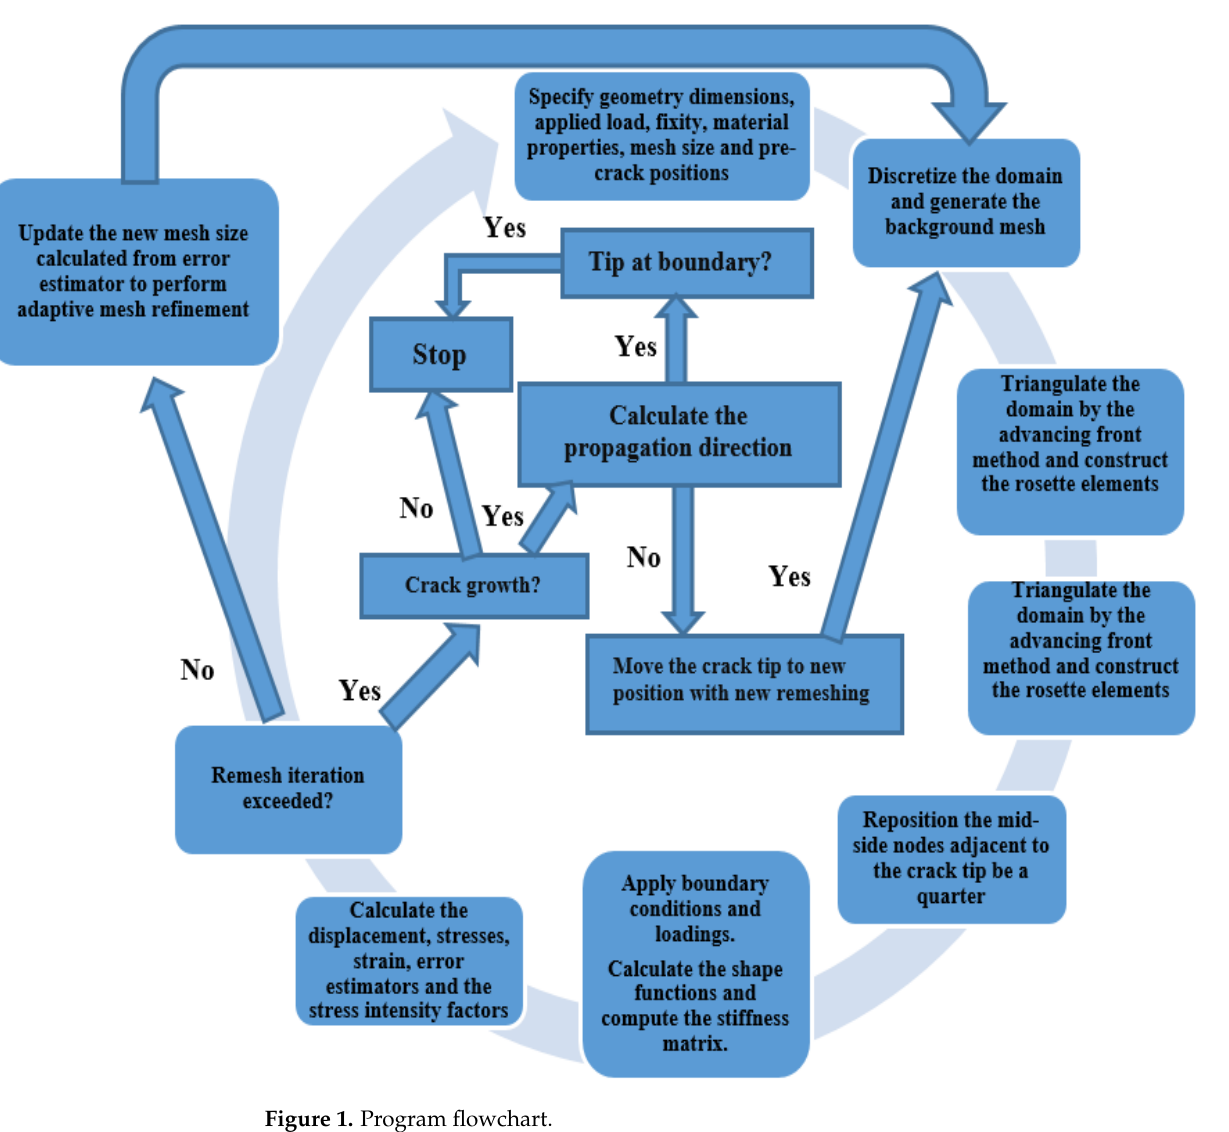
Figure 1. Program flowchart.